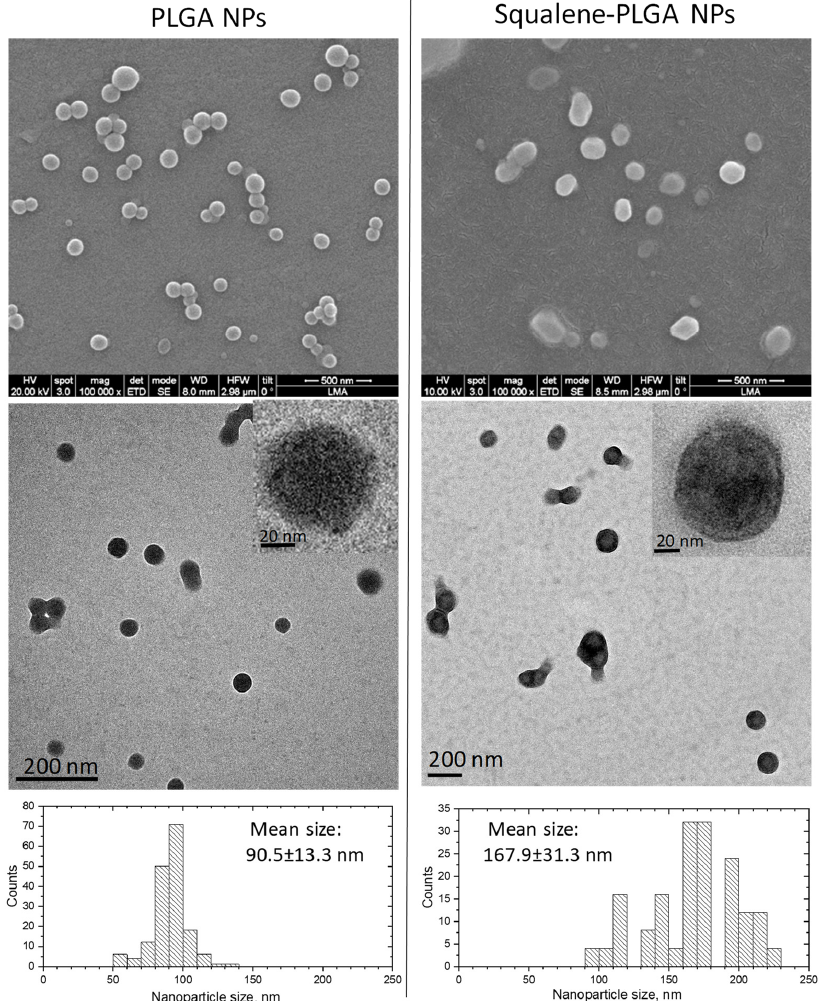
Figure 1. Electron microscopy analysis, SEM, TEM and particle size histograms of PLGA nanoparticles with and without squalene. Table 2. Physicochemical characterization of PLGA nanoparticles.